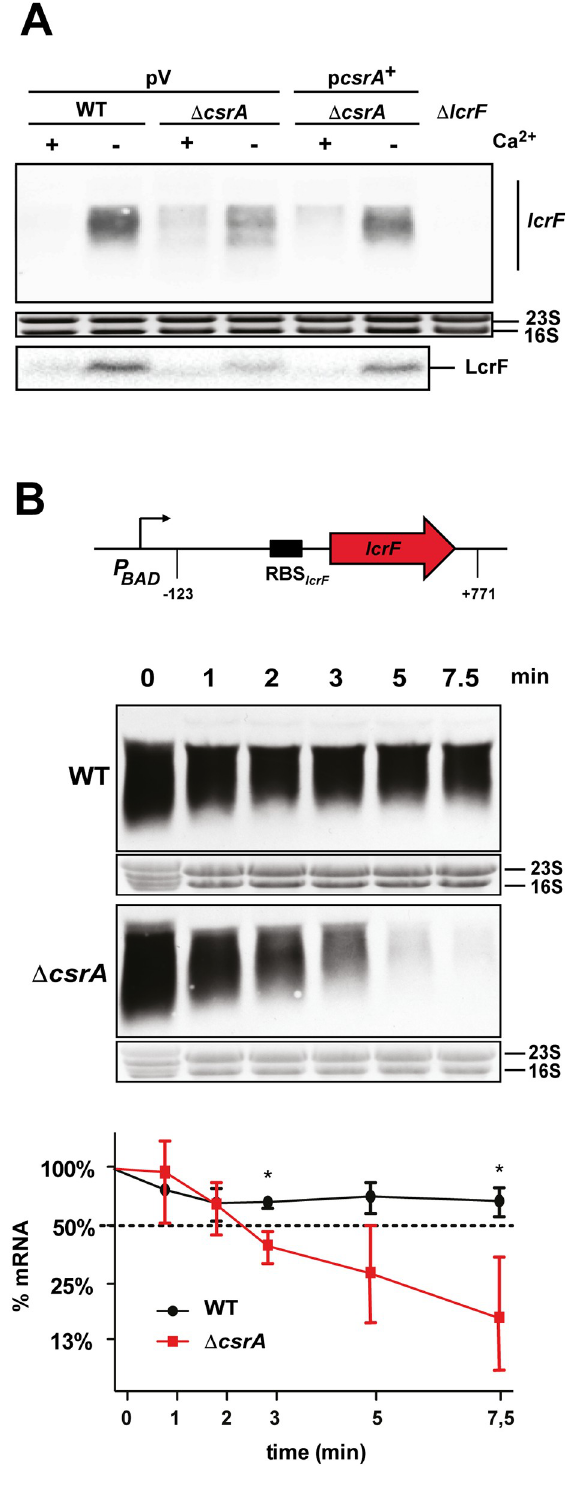
Fig 3. Influence of CsrA on lcrF transcript stability. (A) Y . pseudotuberculosis strains YPIII (WT), and YP53 ( Δ csrA ) harboring the empty vector pV (pHSG576) or p csrA + (pKB60) were grown to exponential phase (OD 600 of 0.5) at 25˚C and then shifted to 37˚C in the presence (+) or absence (-) of Ca 2+ by addition of 20 mM sodium oxalate and 20